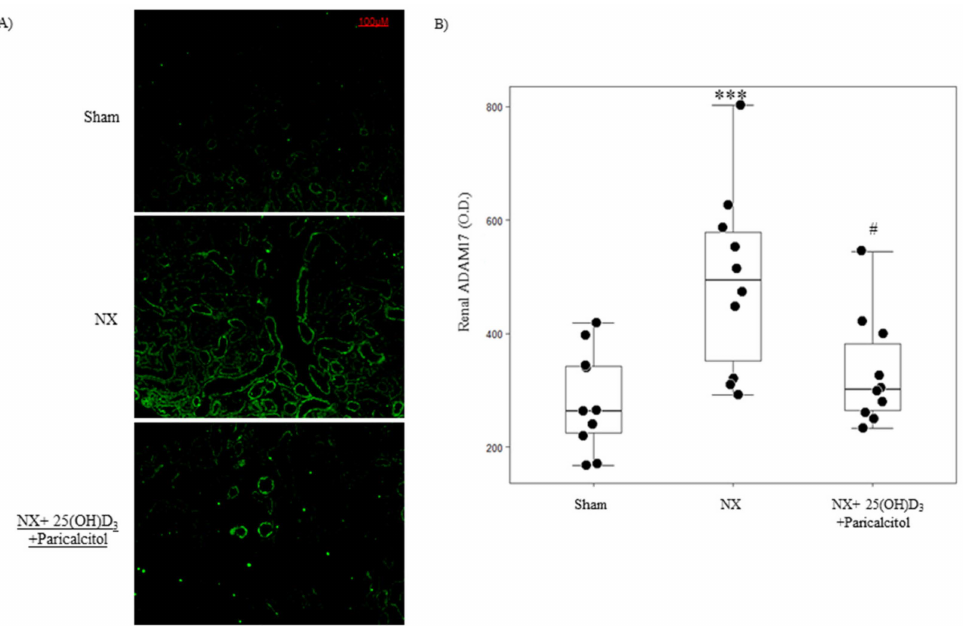
Figure 1. Vitamin D prevents uremia-induced increases in renal ADAM17 protein. ( A ) Representa- tive images of ADAM17 immunofluorescence and ( B ) and its quantification in kidneys from mice subjected to 75% NX and exposed to vehicle (NX group, n = 10) or to the combination of 25(OH)D 3 and paricalcitol (25(OH)D 3 : 80 ng/mice i.p. weekly and Paricalcitol: 2.6 ng/mice i.p. thrice weekly; NX + 25(OH)D 3 + Paricalcitol, n = 10) for 6 weeks, after 8 weeks of uremia in mice fed a normal diet. A group with normal renal function was used as control (Sham group, n = 10). Box plots represent median and interquartile range; *** p < 0.001 vs. Sham and # p < 0.05 vs. NX group.